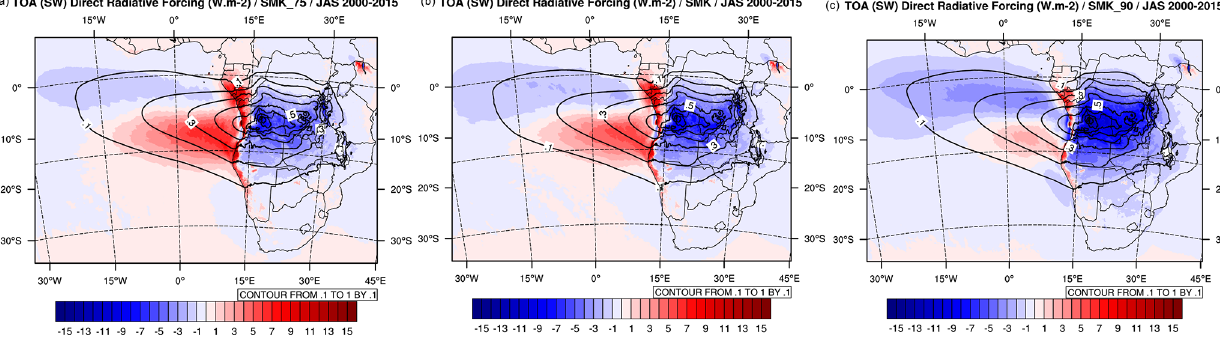
Figure 13. Seasonal-mean (JAS) BBA DRE (Wm − 2 ) at TOA exerted in the shortwave (all-sky conditions) for the three ALADIN simulations (SSA of 0.75, a ; 0.85, b and 0.90, c ) and for the period 2000–2015. The AOD of BBAs are indicated by the black